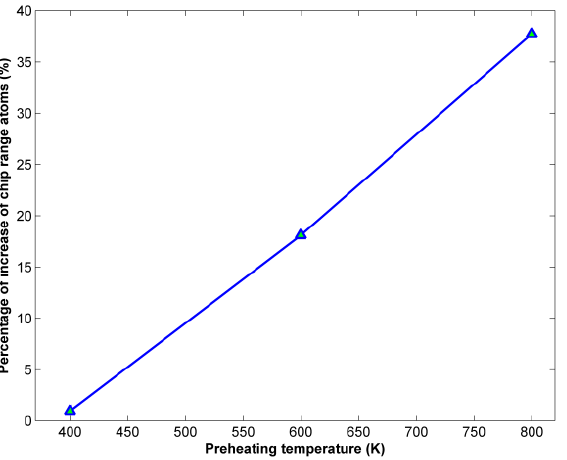
Figure 5. Variation of chip range atoms percentage of increase with respect to preheating tempera- ture.